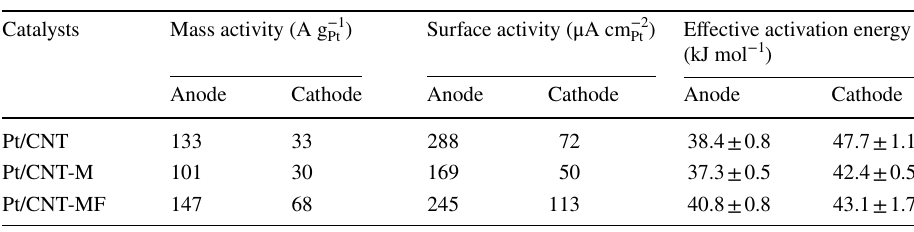
Table 4 Electrochemically active surface area of Pt obtained in MEA (EAS PtMEA ) as the total Pt surface (cm 2 ), specific Pt surface area (m 2 g Pt−1 ), maximum power densities and utilization ratio obtained in electrochemical cell and MEA Fig. 7 Nyquist plots for the catalysts measured at potentials 0.8 V (1), 0.6 V (2), 0.4 V (3) and 0.3 V (4). Real and imagi- nary parts of impedance were corrected for the electrochemi- cally active surface of Pt in MEA (Table 4). In the inset, the high-frequency regions are pre- sented without EAS